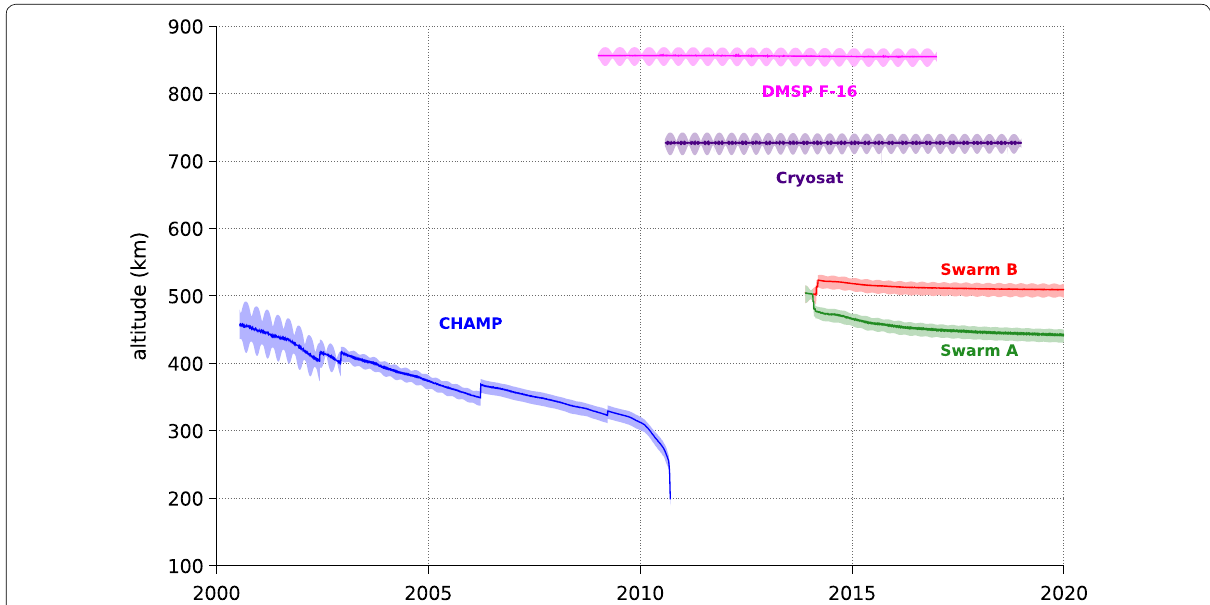
Fig. 1 Altitude evolution of the satellite missions used for this study. Solid curves are daily mean altitudes. Envelope curves are the daily minimum and maximum altitudes. Only one DMSP satellite is shown since the altitude profiles of the other two are nearly